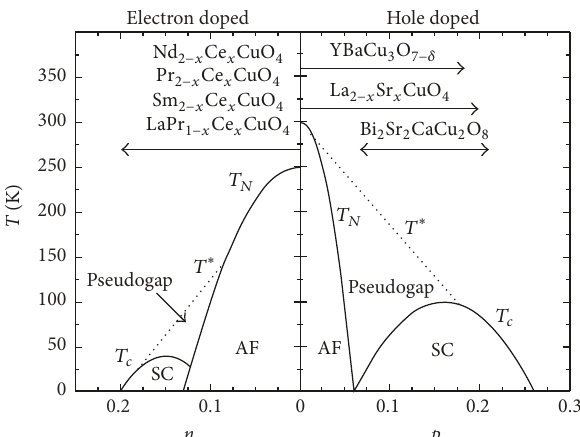
Figure 1: Simplified doping-dependent phase diagram of cuprate superconductors for both electron ( 𝑛 ) and hole ( 𝑝 ) doping. The phases shown are the antiferromagnetic (AF) phase close to zero doping, the superconducting phase around optimal doping, and the pseudogap phase. Doping ranges possible for some common compounds are also shown, after